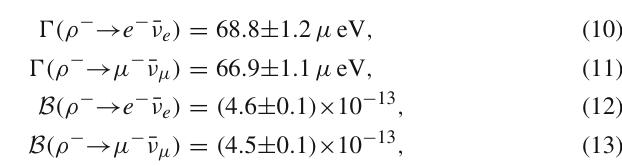
lifetime τ τ = 290 . 3 ( 5 ) fs [1], and branching ratio B (τ → ρν) = 25 . 19 ( 33 ) % [1], one can easily extract the decay con- stant f exp